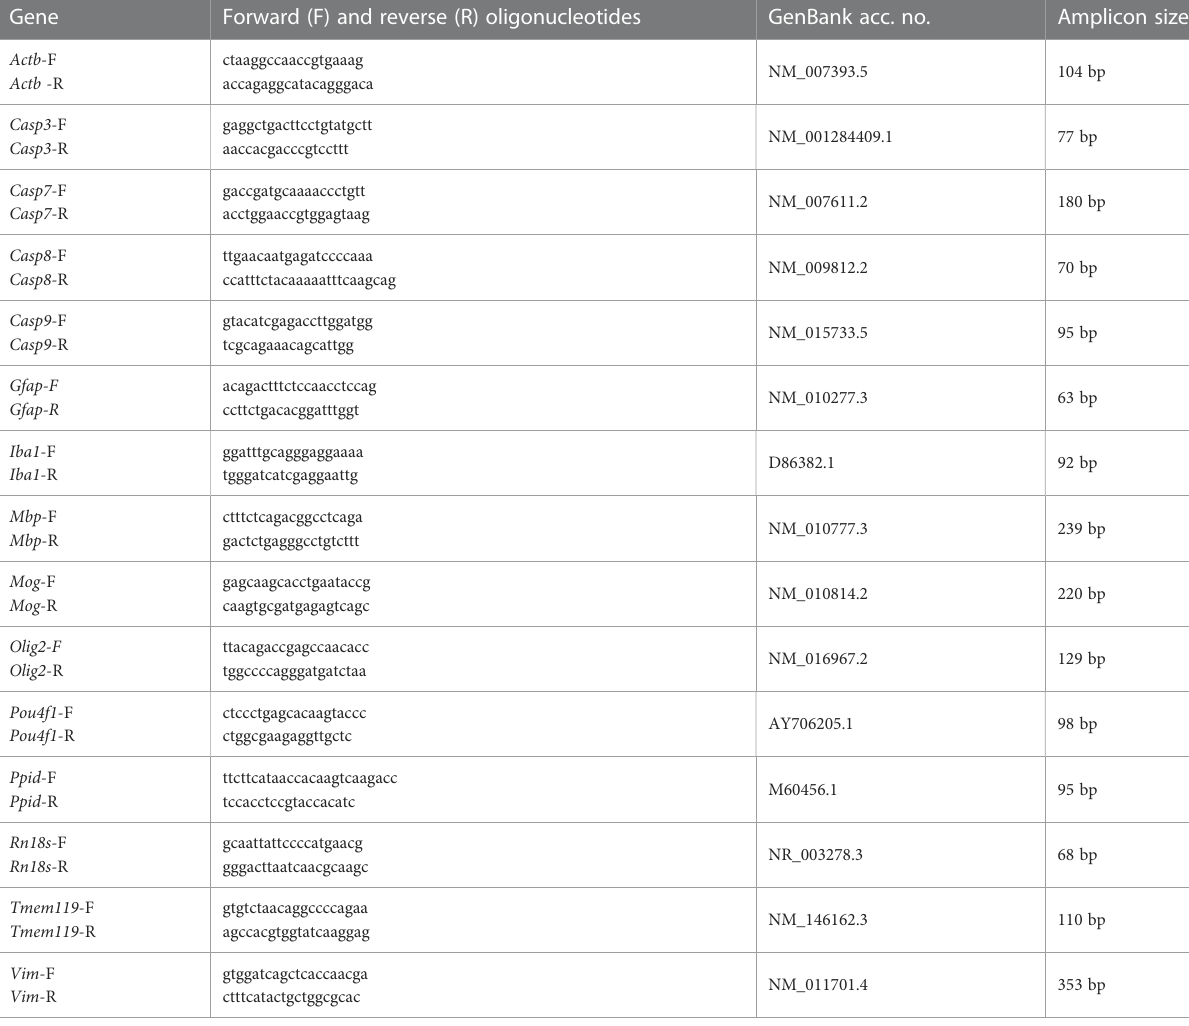
TABLE 1 Sequences of oligonucleotides. Gene Forward (F) and reverse (R)